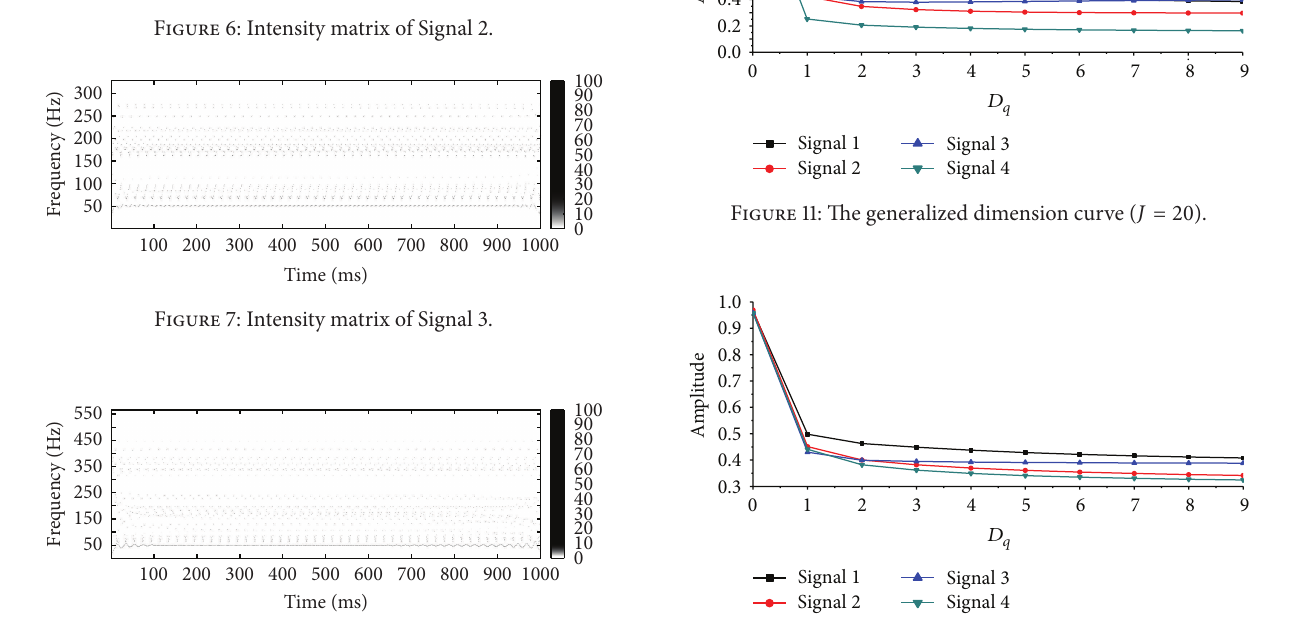
Figure 8: Intensity matrix of Signal 4.